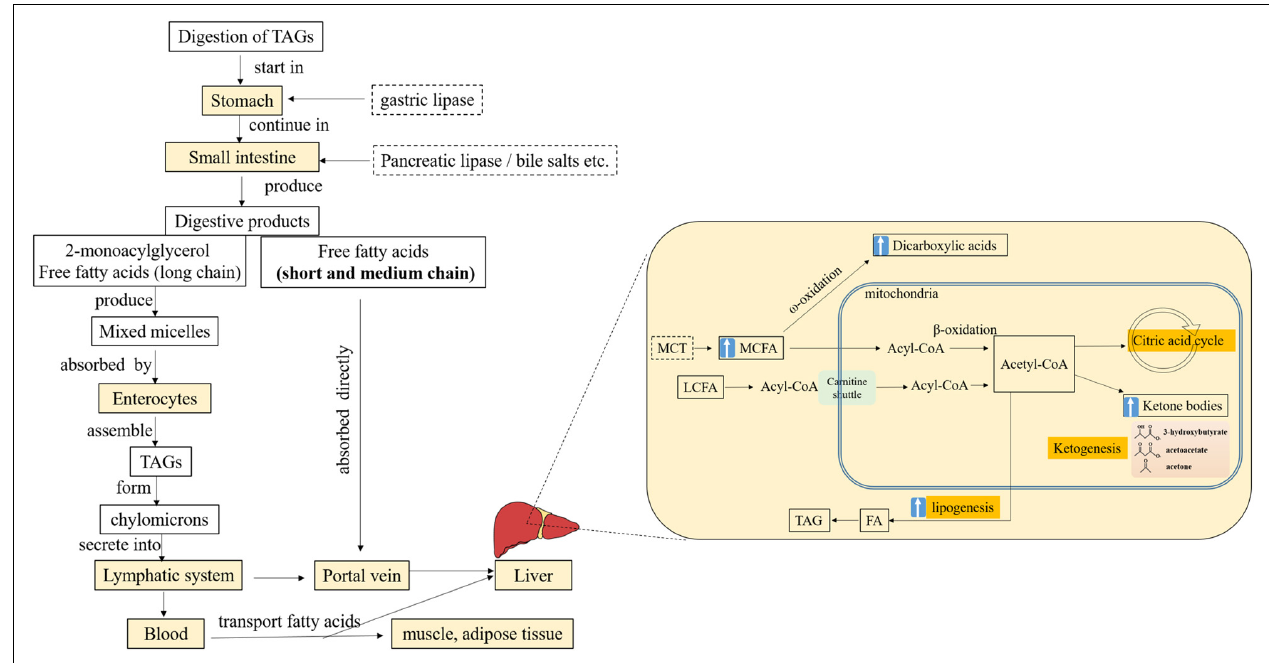
FIGURE 1 | Simplified schematic of digestion, absorption, and transport of MCFAs from TAGs and the metabolism of MCFAs in the liver. FA, fatty acid; MCFA, medium-chain fatty acid; MCT, medium-chain triacylglycerol; LCFA, long-chain fatty acid; TAG, triacylglycerol; “ ↑ ,” enhanced. Adopted from